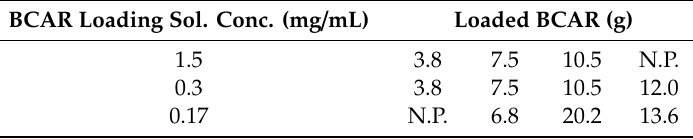
Table 1. BCAR loading solutions and loaded amounts. BCAR Loading Sol. Conc. (mg /